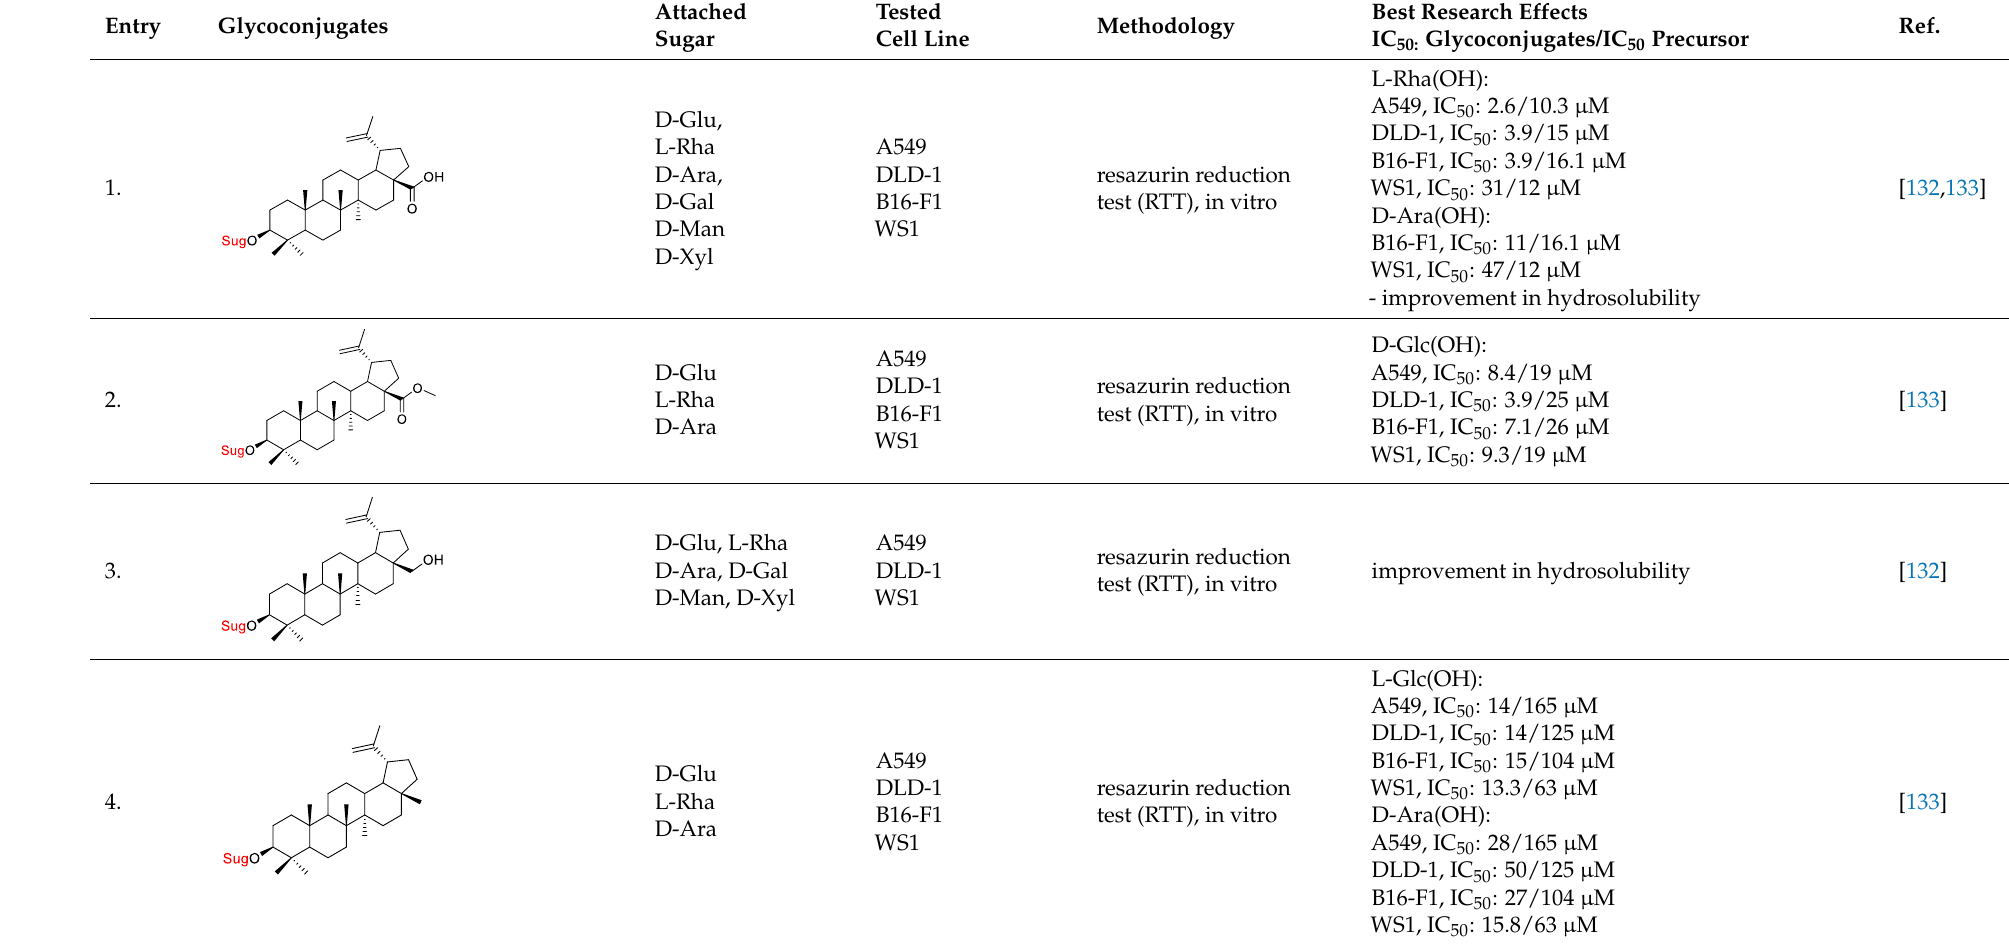
Table 2. Representative glycoconjugates from triterpenoids (lupeol, BN, BA).